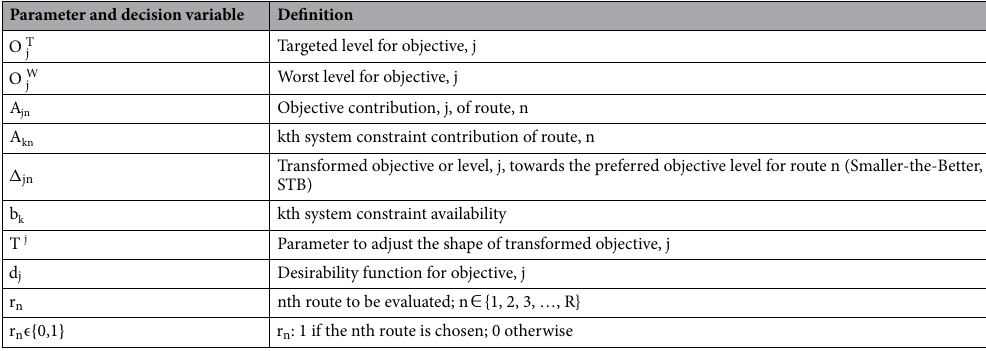
Table 1. Parameters and decision variables for route selection, including